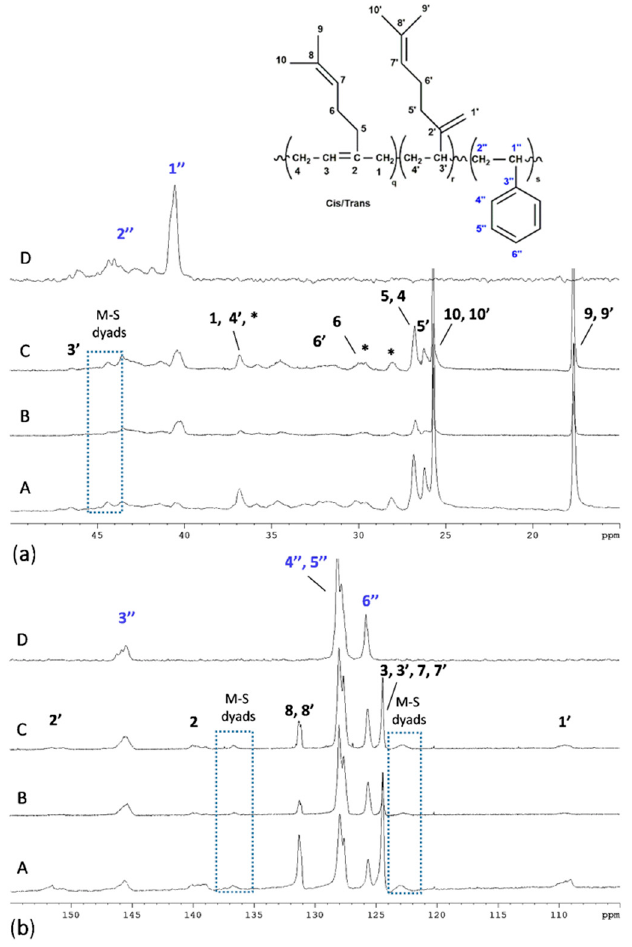
Figure 2. Aliphatic ( a ) and olefinic ( b ) regions of 13 C NMR spectra (TCDE, 25 ◦ C, 400 Mhz) of PMS, synthesized at different myrcene : styrene ratios, and of PS homopolymer. A) M:S (mol/mol) = 70:30 (run 12, Table 2); B) M:S (mol/mol) = 50:50 (run 13, Table 2); C) M:S (mol/mol) = 30:70 (run 14, Table 2); PS (run 5, Table 1). * Signals attributed to head-to-head and tail-to-tail regio-irregular 1,4 M units.